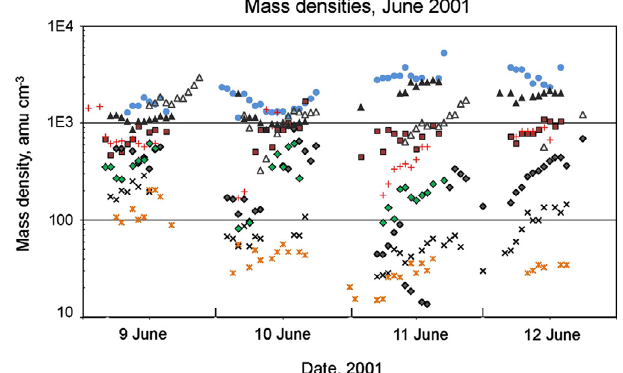
Fig. 9. FLR-derived mass densities for 9–12 June 2001. Symbols are as follows: L = 2.4, LT = UT = blue circles; L = 2.6, LT = UT = black triangles and LT = UT – 5 = open triangles; L = 3.2, LT = UT = brown squares; L = 3.6, LT = UT + 1 = plus symbols; L = 3.9/4.0, LT = UT = grey diamonds and LT = UT + 1 = green diamonds; L = 4.7, LT = UT + 1 = crosses; L = 5.7, LT = UT + 1 = orange